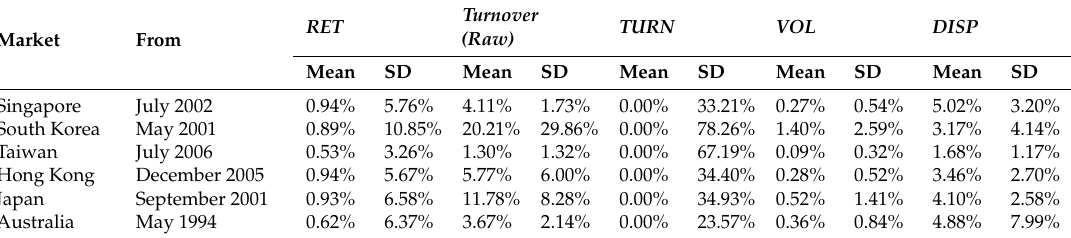
Table 1. Descriptive statistics in Asia Pacific REIT